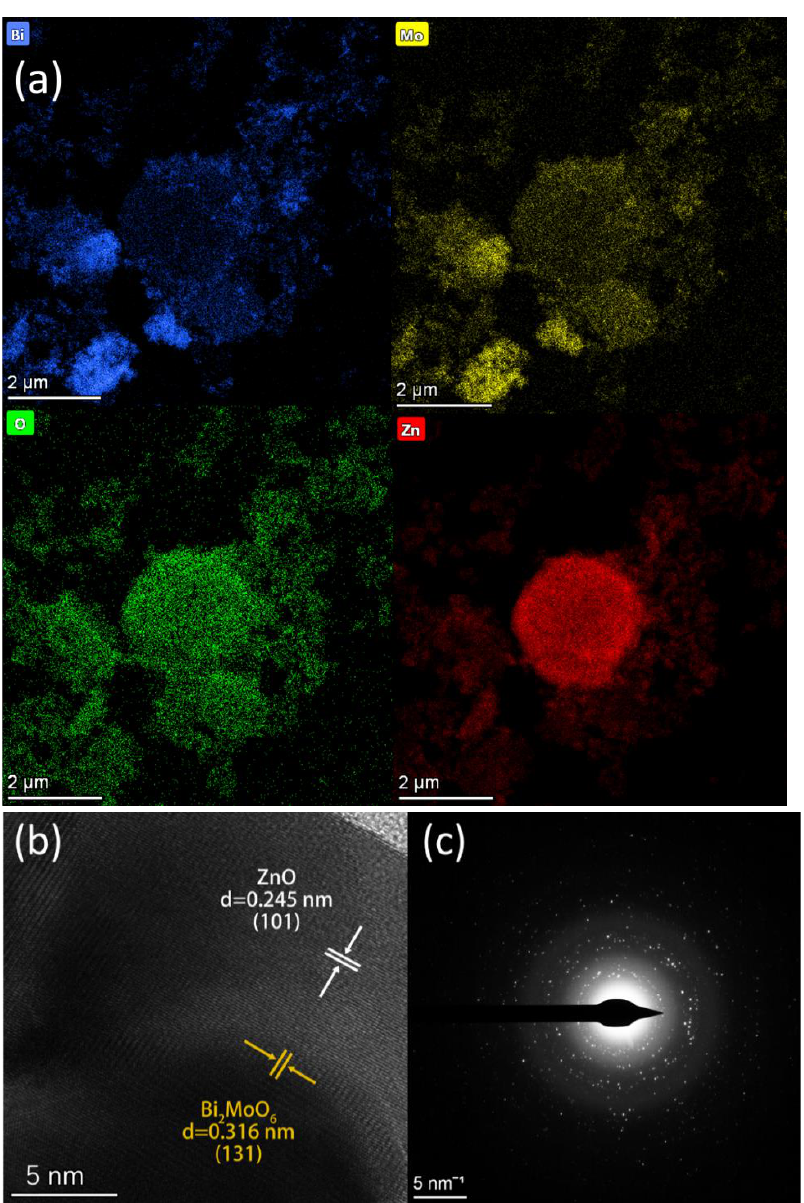
Figure 5. ( a ) TEM image and elemental mapping images of Bi, Mo, O, and Zn of BZO, ( b ) lattice fringes of BZO, and ( c ) SAED diagram of BZO.